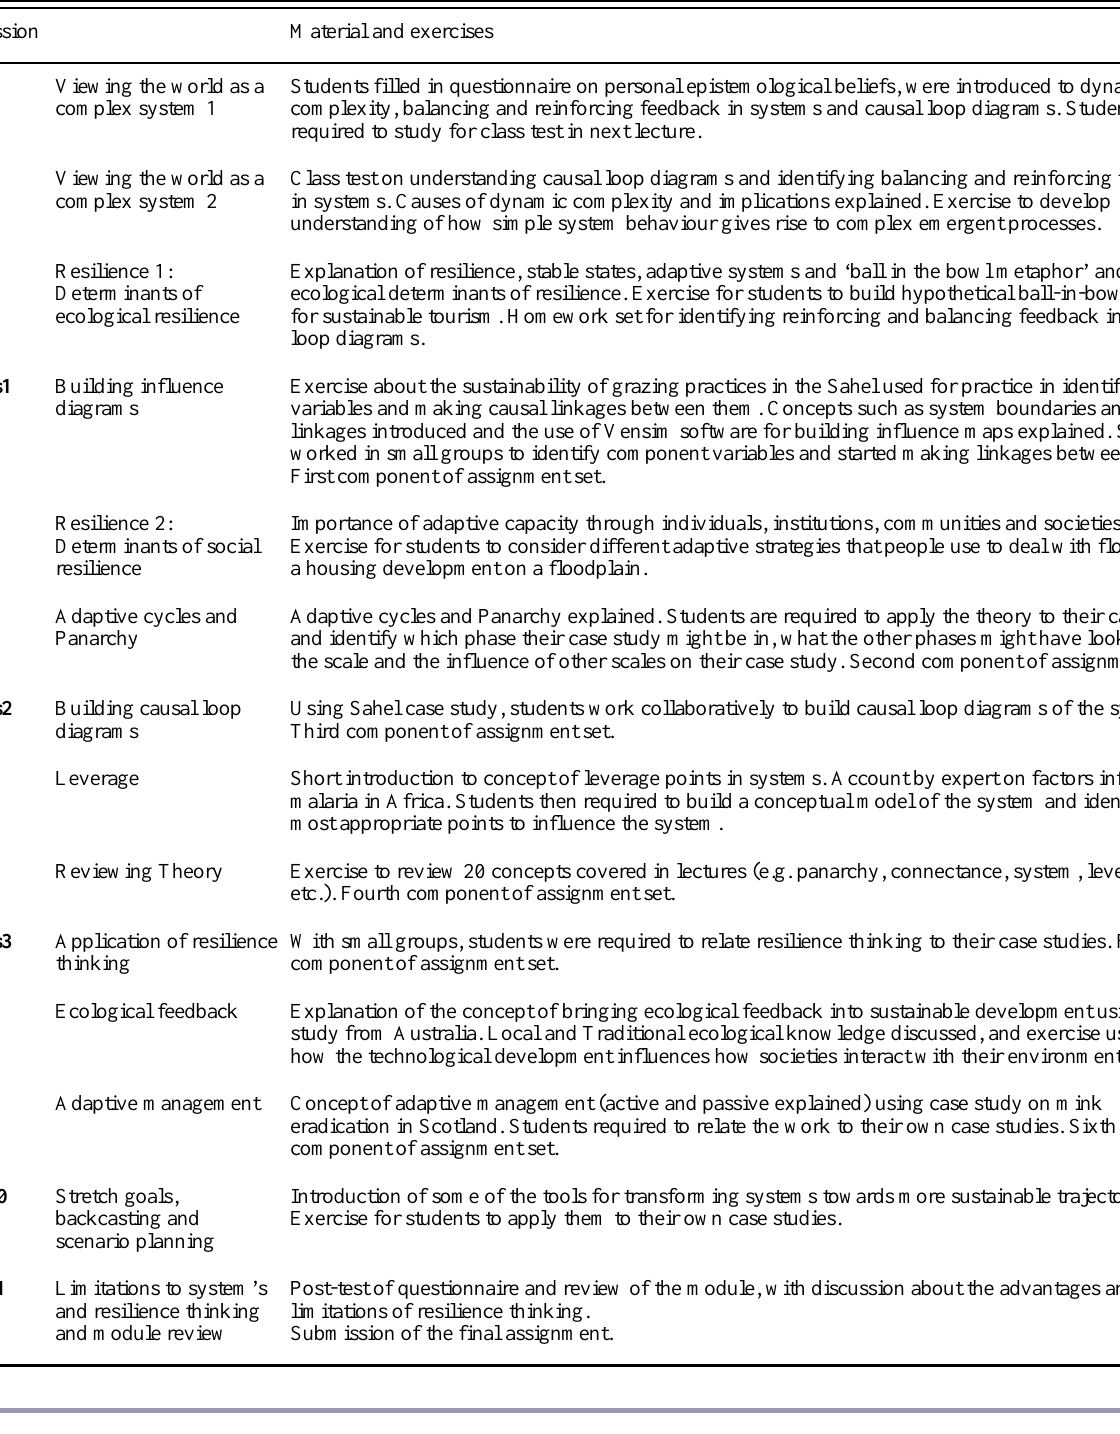
Table 5 . Lecture and workshops in the module. L = lecture and Ws = Workshop. All class exercises were collaborative with students working in small groups which usually included students working on the same case